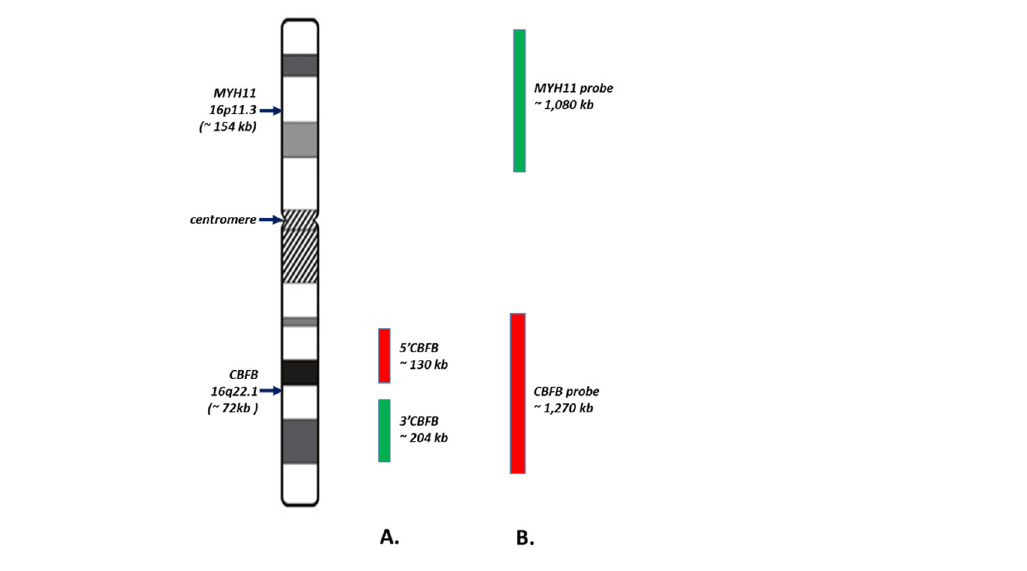
Table 1. Summary of CBFB BAP FISH Results on 1629